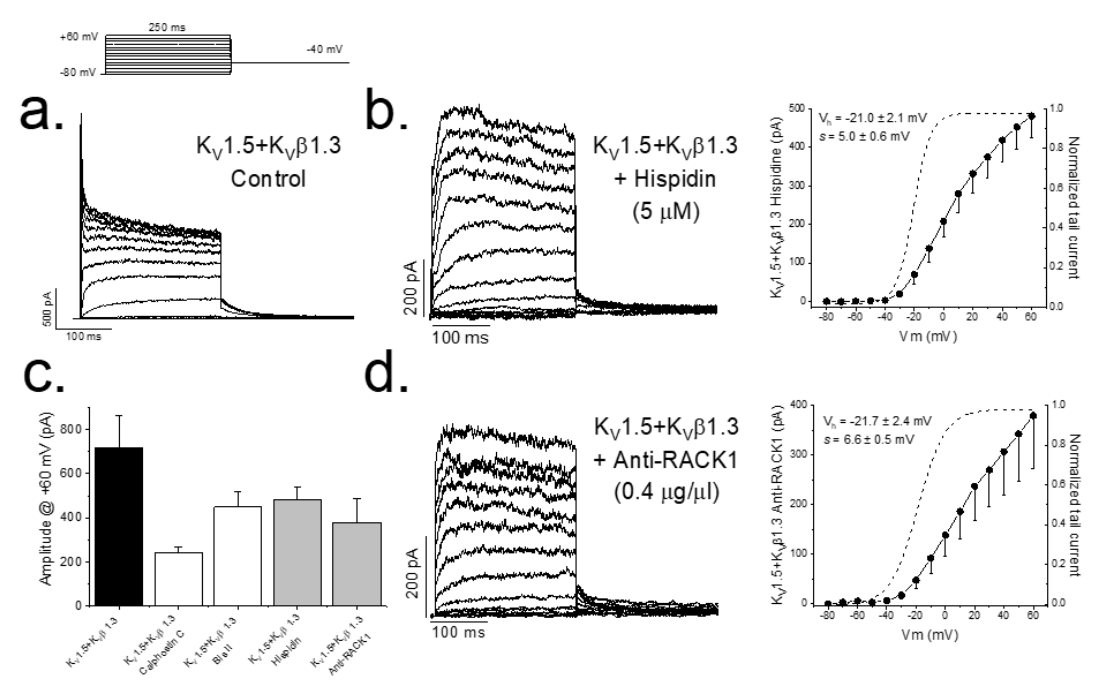
Figure 1. PKC inhibition and RACK1 block results in a smaller magnitude of the K V 1.5–K V β 1.3 current. Representative currents and I–V relationships in control conditions ( a ) along the activation curves, in a dashed line (right), after PKC inhibition with hispidin ( b ) and in the presence of anti-RACK1 antibody into the internal solution ( d ). Graphs shown in ( c ) show a summary of the magnitude K V 1.5–K V β 1.3 current measured at the end of +60 mV depolarizing pulses under control conditions and after inhibition of PKC (with different inhibitors) and after RACK1 block with anti-RACK1 present in the internal solution. Note that data for calphostin C and bisindolylmaleimide II are taken from data previously reported in Macias et al., 2014 [10].